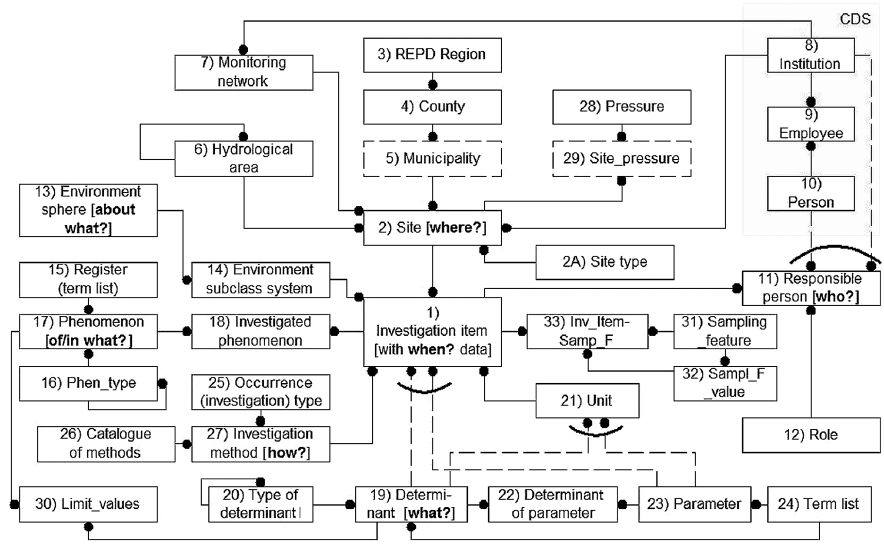
Fig. 4. Relationships between entities of the e-service composition system